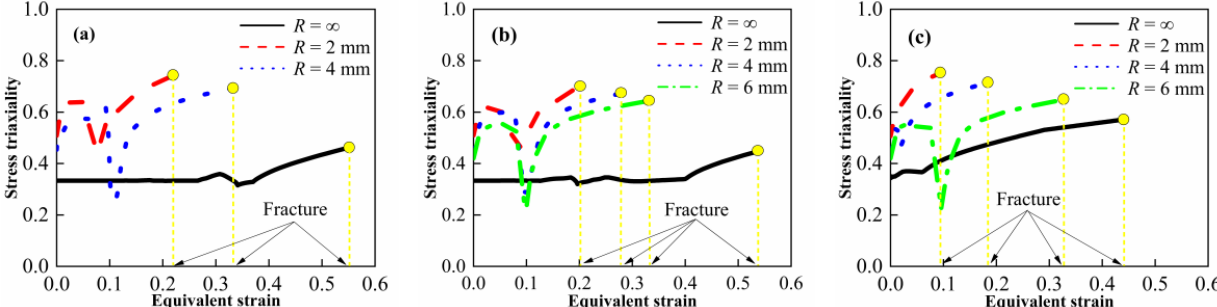
Figure 9. Stress triaxiality varies with equivalent strain for ( a ) M20, ( b ) M50 and ( c ) M80.